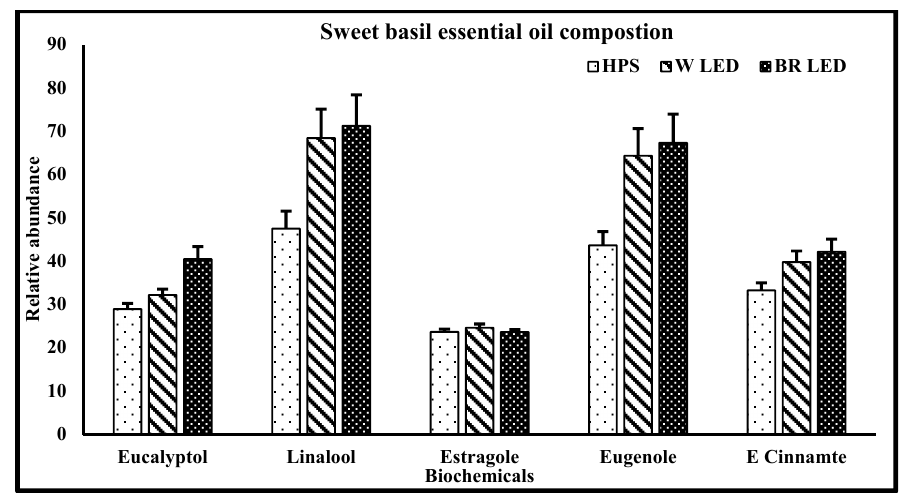
Figure 10. The effect of light treatments on the composition of essential oil in sweet basil (LSD = 17.3 for the lighting treatment). Relative abundance shows the average intensity of biochemical